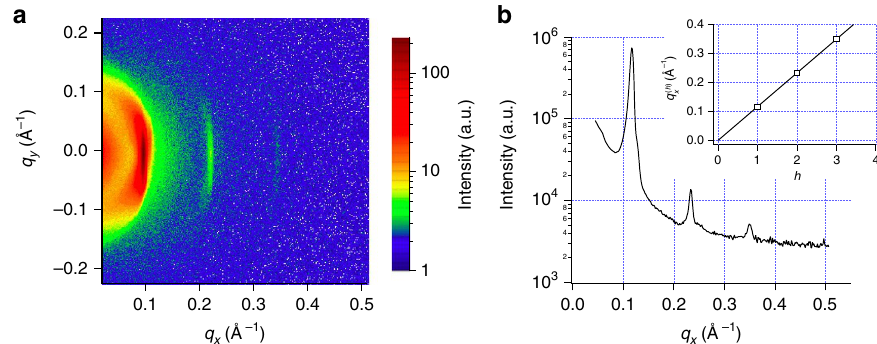
Figure 7 | Lamellar period at excess hydration. Neutron diffraction of pure DGDG measured in excess D 2 O between two silicon wafers. ( a ) 2D diffraction pattern. ( b ) 1D reduced curve. The insert is a plot of the Bragg reflection ( h ¼ 1 to 3) positions versus h . The solid line is a linear fit to the experimental points yielding a period of 54.0 ± 0.1Å.